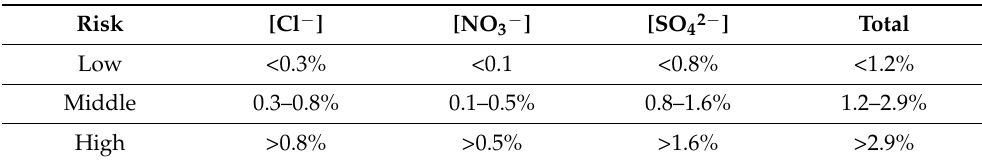
Table 5. Degree of contamination by dangerous soluble salts expressed in weight percentage ( w/w %) according to WTA (International Association for Science and Technology of Building Maintenance and the Preservation of